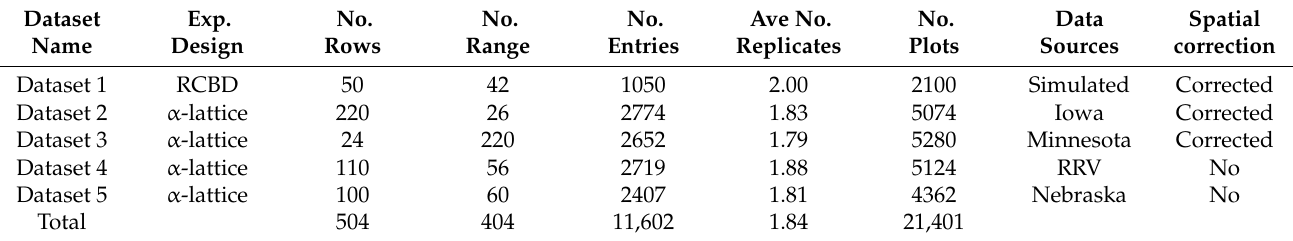
Table 1. Summary of the five data sets used in the study. RRV for Red River Valley, ranges, rows for columns and horizontal rows of an experiment field, and testing lines for the genotypes under testing to be discarded/advanced for a variety. Dataset 1 is simulated, and datasets 2 to 5 are experimental field data.